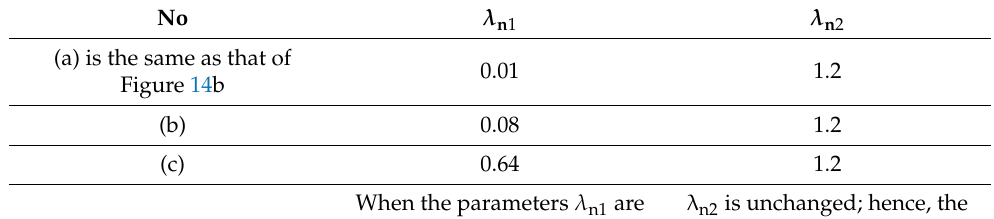
Table 3. Selection schemes and conclusions for the three parameters in Figure 15.